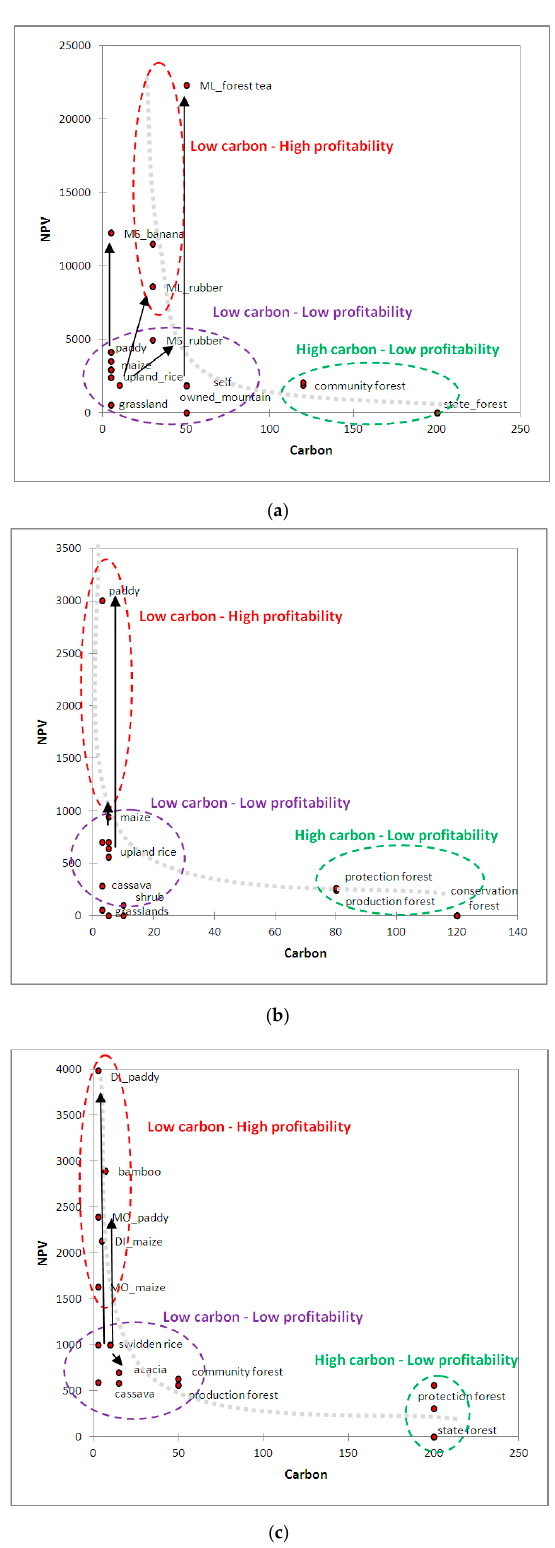
Figure 4. Trade ‐ off curves of land ‐ use systems in the three research sites: ( a ) China; ( b ) Laos; ( c ) Figure 4. Trade-off curves of land-use systems in the three research sites: ( a ) China; ( b ) Laos; Vietnam. ( c )